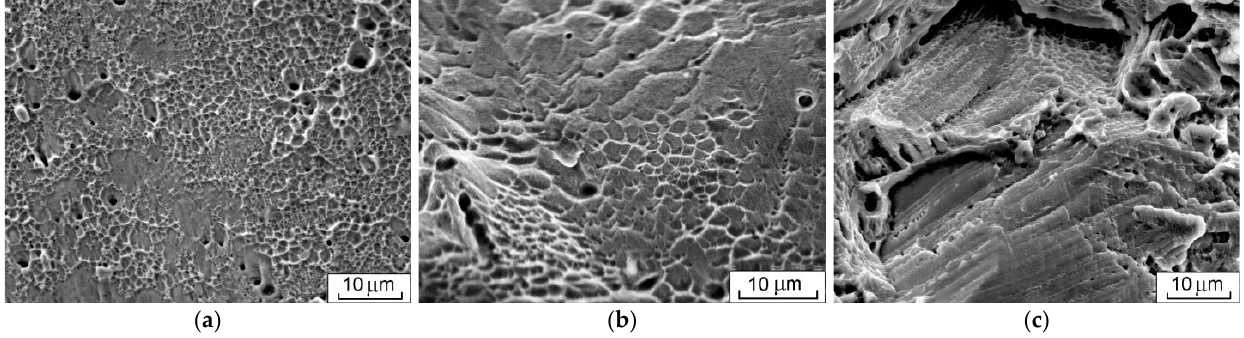
Figure 5. The fracture surfaces of the samples after the tensile tests at T = −30 °C ( a ), T = −80 °C( b ) and T = −196 °C ( c ).